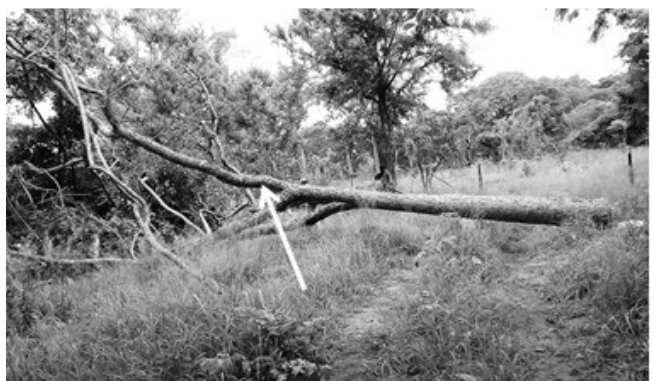
Figure 1. Definition of stem section for a felled tree based on tree